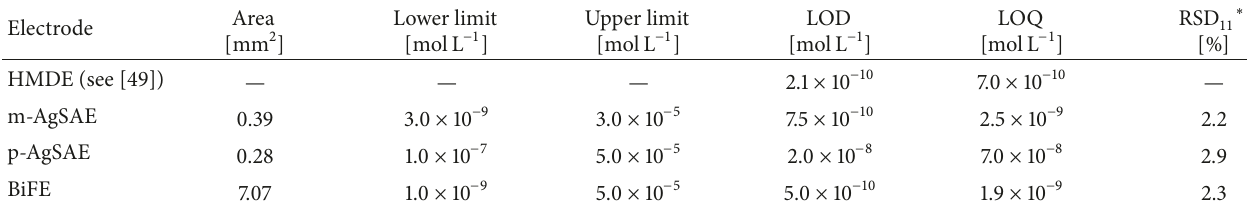
Table 7: Statistical parameters of DAN determination using all tested working electrodes (DPAdSV, BRB (pH 5.0 (BiFE), 6.0 (the other ones)), 𝐸 𝐸 = − 1300mV, V = 40mVs −1 , pulse height = − 50mV (BiFE), − 60mV (the other ones), pulse width = 60ms (BiFE), 40ms in = +200 mV, fin (the other ones), 𝐸 = +200 mV, and 𝑡 = 0–100s (in dependence on 𝑐 acc acc